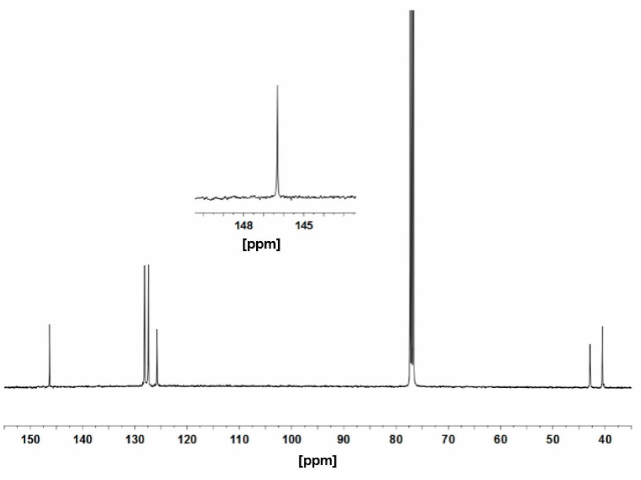
Figure 2. 13 C{ 1 H} NMR spectrum of polystyrene obtained by the 9 /dMAO system at 0 ˝ C (Table 1, Run